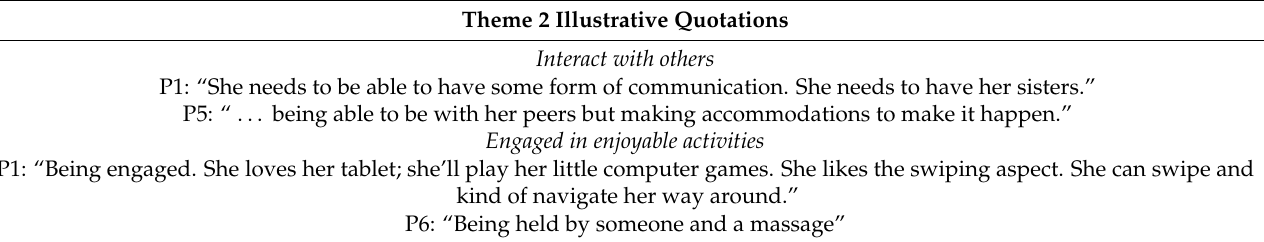
Table 3. Theme 2 Feeling Included and